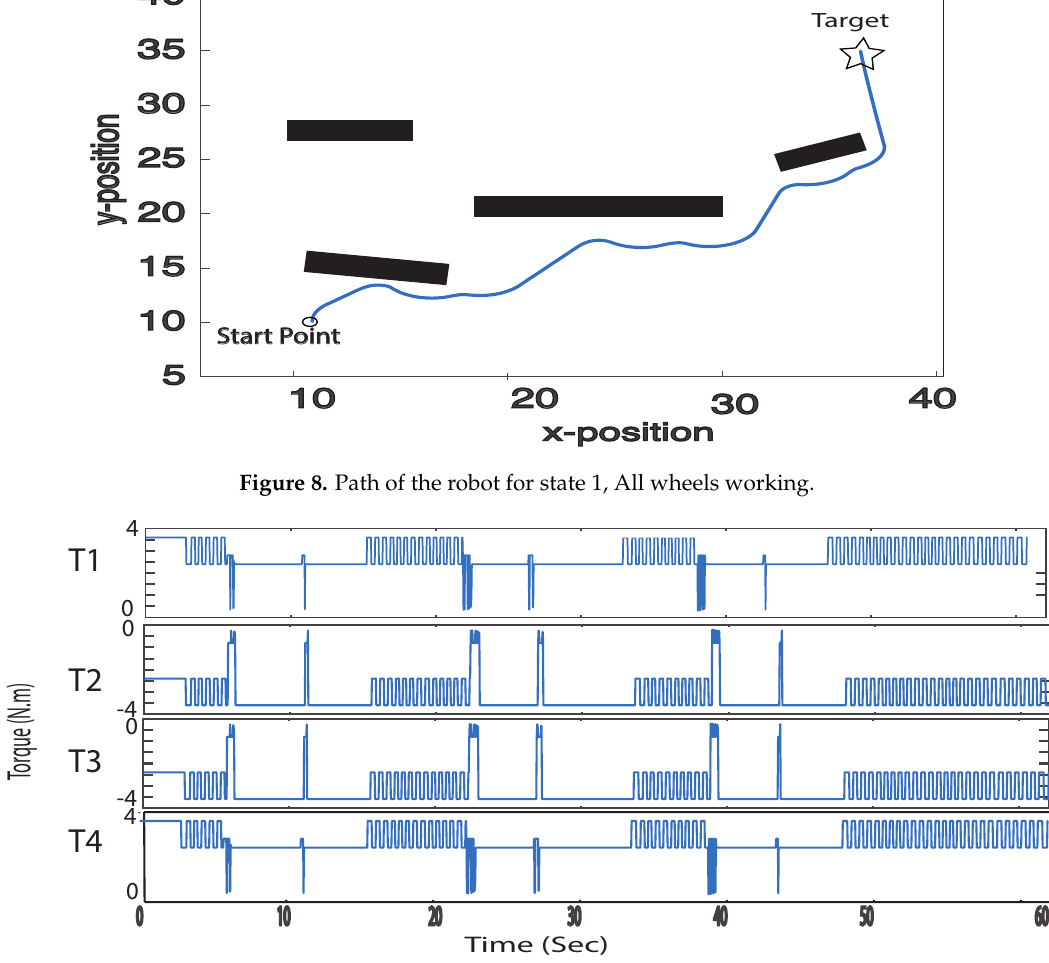
Figure 9. Simulation Results for State 1: Torque of motor 1,2,3,4 (All wheels working).